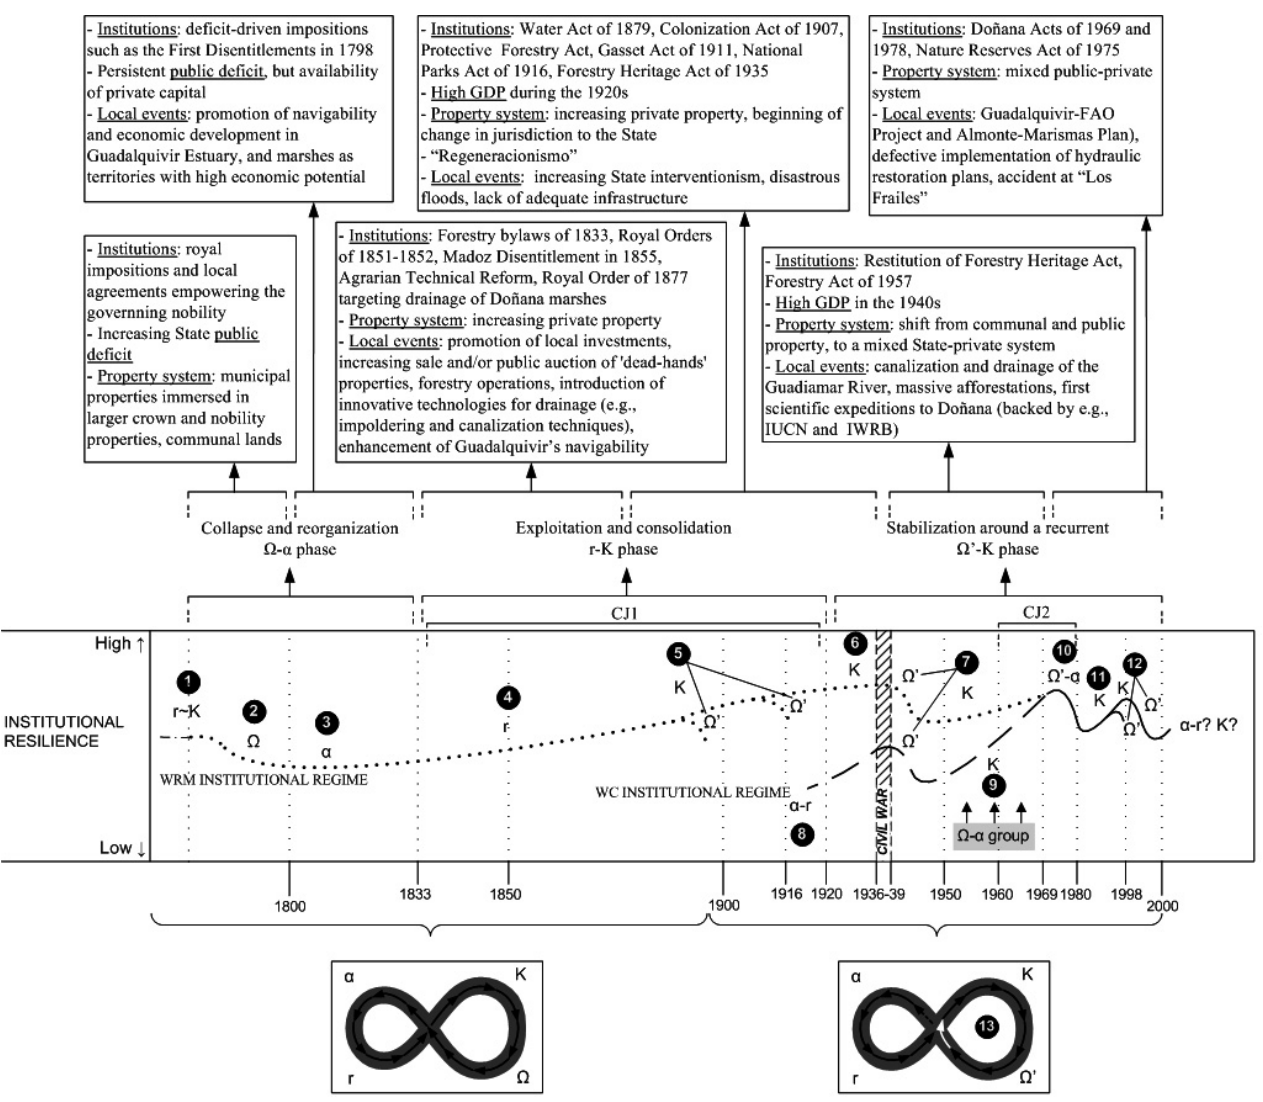
Fig. 3 . Historical development of Doñana's institutional regimes for water resource management (WRM) and wetland conservation (WC), interpreted through the adaptive-cycle heuristic, and concomitant changes in institutional resilience. Dates and description profiles of institutional events are provided in Appendix